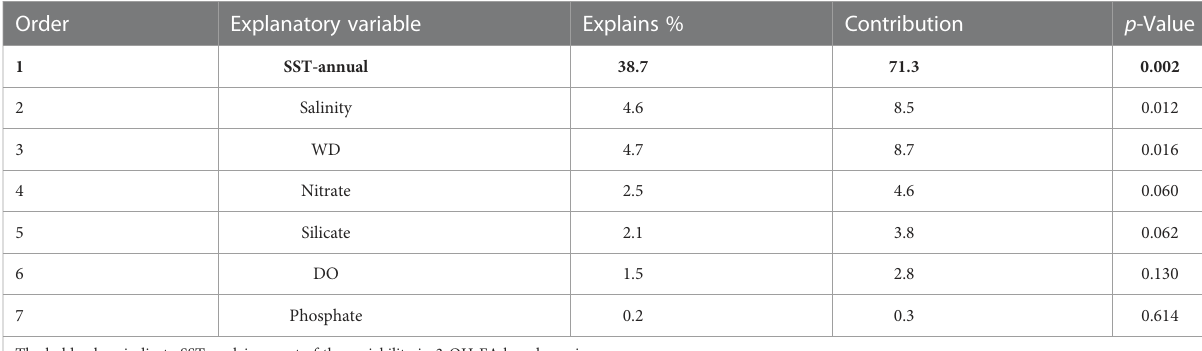
TABLE 1 Results of the RDA showing the contribution of environmental parameters to the variance of 3-OH-FA based proxies (RAN 13 , RIN 17 and RANs) in the marine sediments.